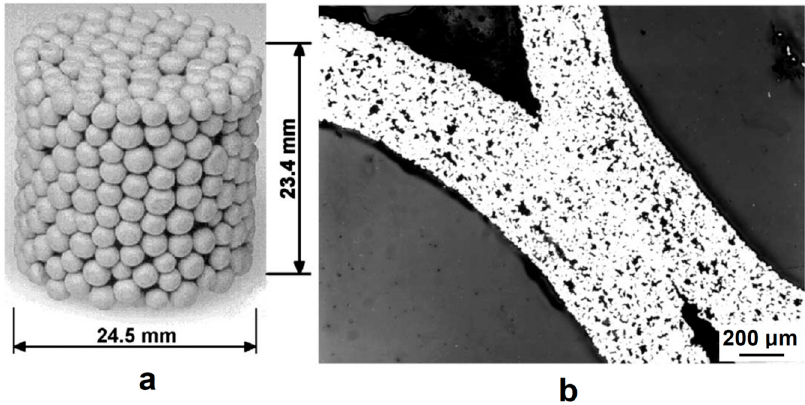
Figure 12. General view of the randomly packed steel sphere sample ( a ), porous structure of the cell wall ( b ). Reprinted from Khor et al. [55], Copyright (2003), with permission from Elsevier.